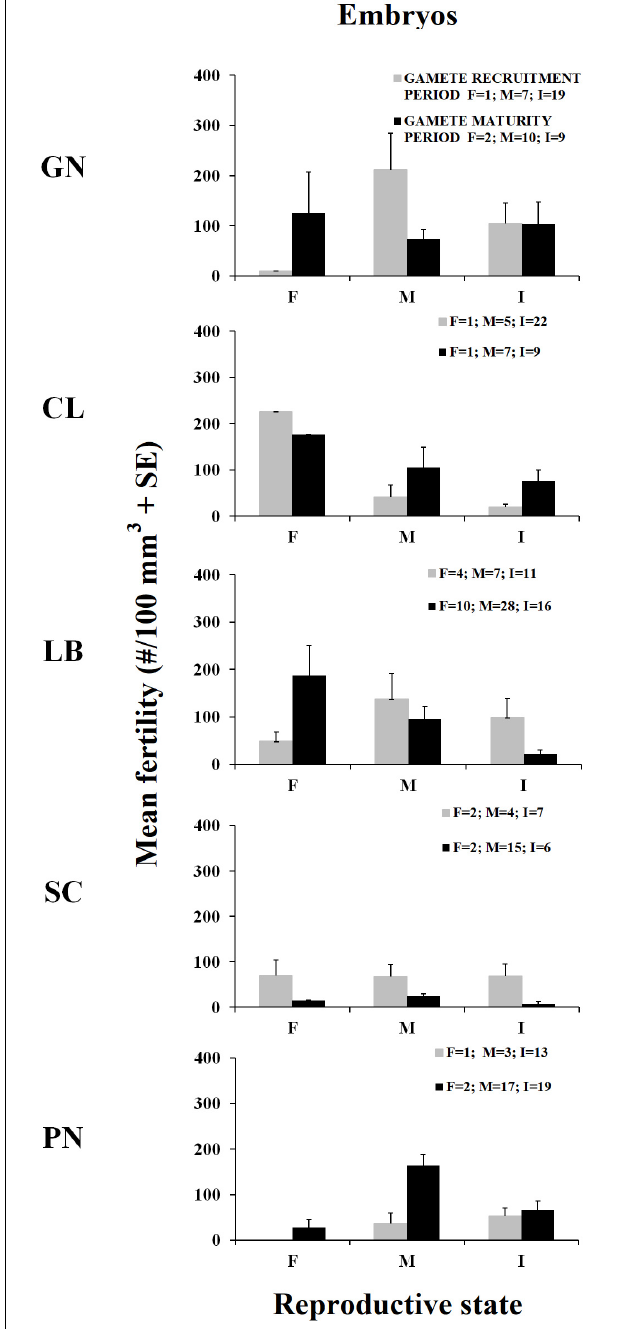
FIGURE 3 | Mean fertility in females (F), males (M), and sexually inactive individuals (I) ± standard error (SE) for the two reproductive periods. Mean fertility during gamete recruitment period (gray histogram bars) and gamete maturity period (black histogram bars). N = number of polyps.